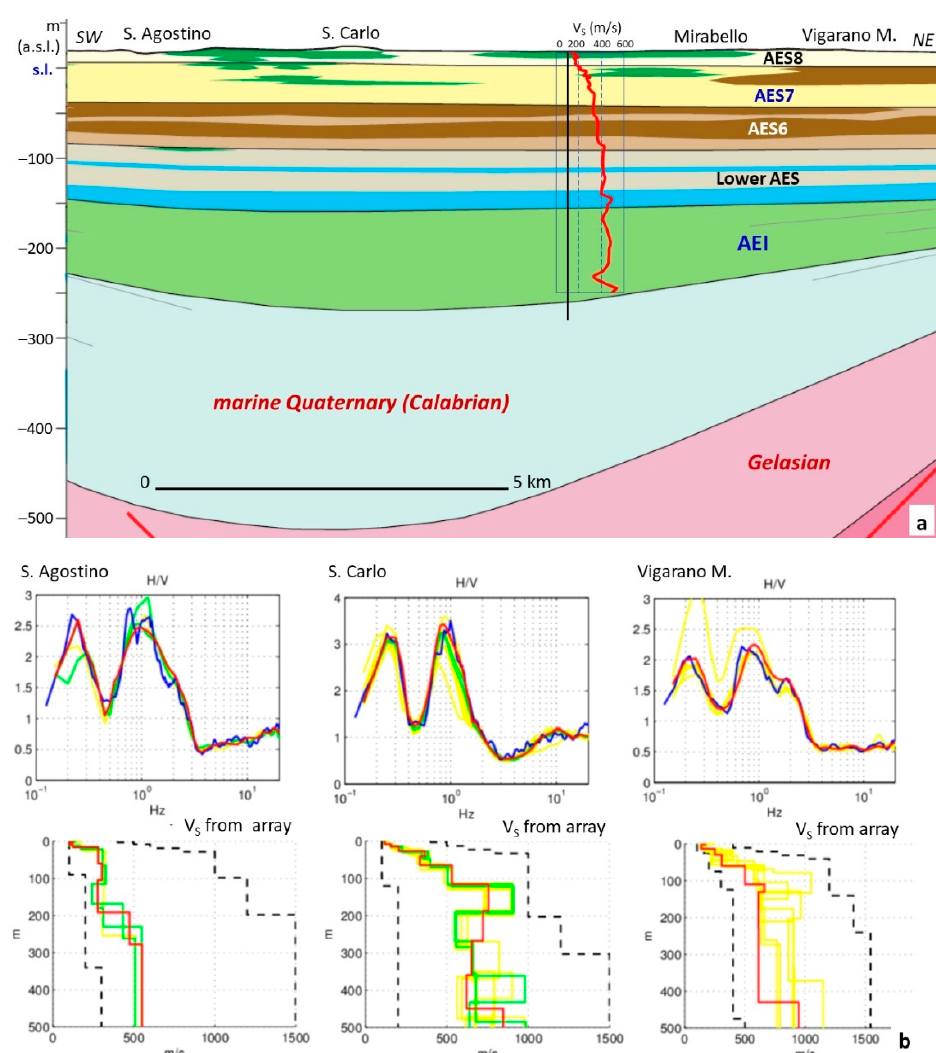
Figure 18. (a) Geological cross-section from Sant’Agostino to Vigarano Mainarda [19] and Vs profile from Mirabello down-hole [36], ( b ) H/V spectral ratios and Vs profiles from ambient vibration measurements (array) [19].